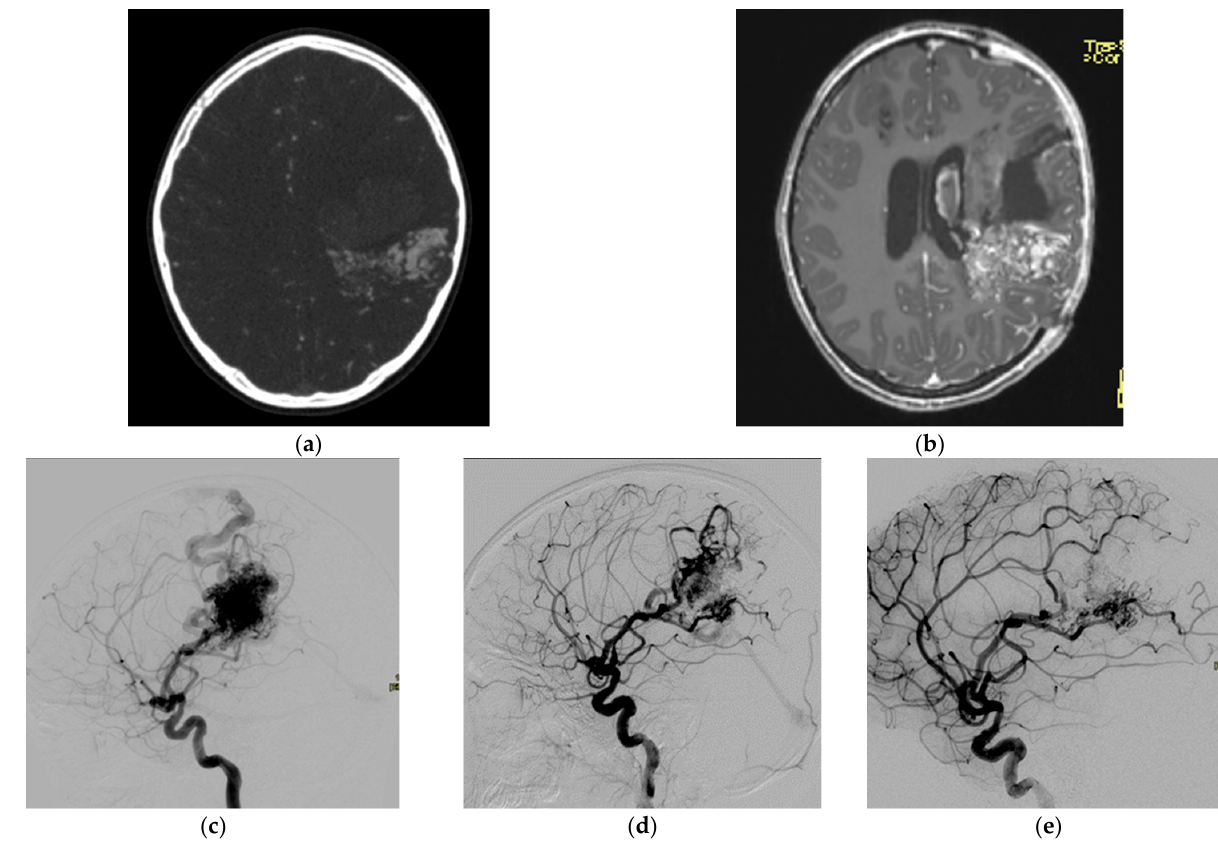
Figure 1. An 8-year-old female with an extensive AVM. AVM is shown on CTA ( a ), MRI ( b ), and DSA in sagittal projection ( c ). The AVM has been treated in staged sessional treatments using liquid embolic agent. The reduction in AVM size after the first treatment session ( d ) has been estimated at 60–80% compared to the starting size. There has been additional reduction in size after the second treatment session ( e ).